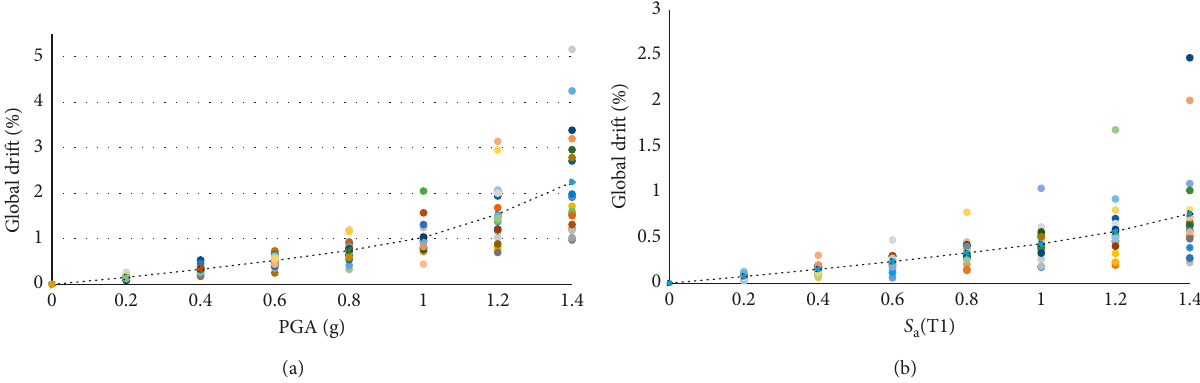
Figure 7: Hazard-damage relationships: (a) PGA v/s global drift in percentage; (b) S